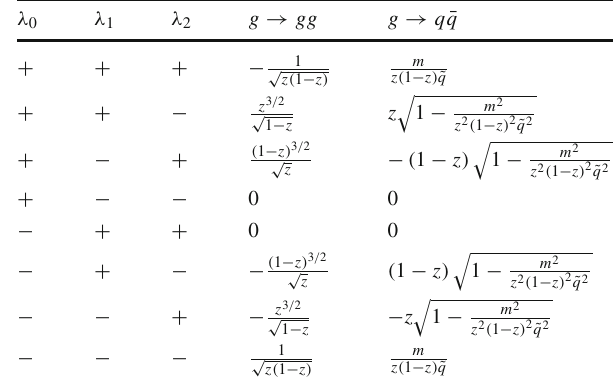
Table 2 Spin unaveraged splitting functions for g → gg and g → q ¯ q . In addition to the factors given above each term has a phase e i φ (cid:3) (λ 0 − λ 1 − λ 2 ) ,where λ 1 , 2 = ± 1foroutgoinggluonsand λ 1 , 2 = ± 1 outgoing quarks. For the g → q ¯ q splitting function ˜ q is the Herwig